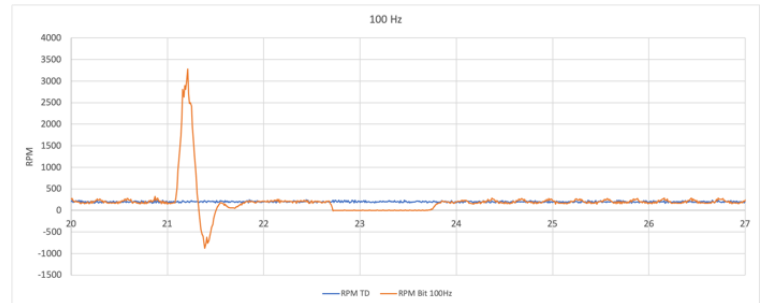
Figure 24. Comparing 1 Hz, 10 Hz, and 100 Hz for similar stick-slip conditions (5 s sticking period).